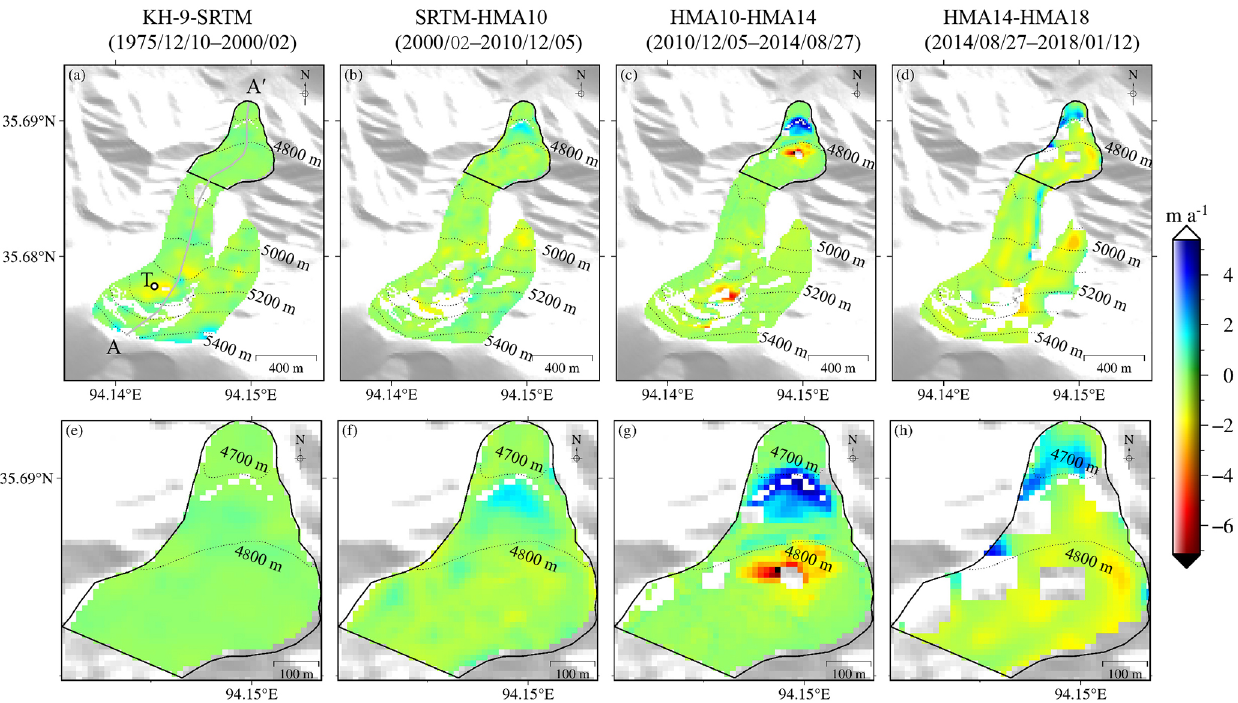
Figure 5. Surface elevation changes of KLP-37 glacier between 1975 and 2018. (a–d) Elevation changes over the full glacier for the DEM pair (e, f) Amplified elevation changes over the glacier tongue region for the four DEM pairs. The dotted black lines indicate the elevation contours.